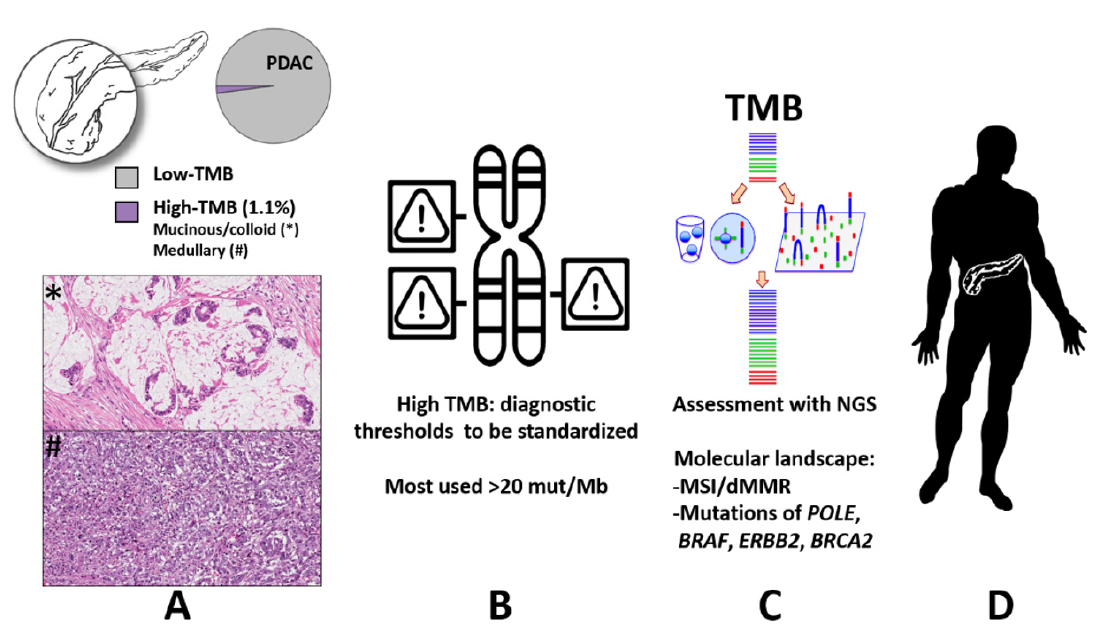
Figure 2. Summarizing figure highlighting the complex landscape related to tumor mutational burden and its potential roles as a biomarker in precision oncology. ( A ) High-tumor mutational burden is relatively rare in pancreatic ductal adenocarcinoma (1.1%), and is enriched in mucinous/colloid and medullary histology (original magnification 10×); ( B ) the most used threshold to distinguish high- vs. low-tumor mutational burden is 20 mutations/Mb; ( C ) tumor mutational burden is assessed with next-generation sequencing, and pancreatic cancers with high-tumor mutational burden display a peculiar molecular landscape, including microsatellite instability/defective mismatch repair, and mutations affecting POLE , BRAF , ERBB2 and BRCA2 genes; ( D ) the routine assessment of tumor mutational burden should be intended as an important step towards the implementation of precision oncology for patients affected by pancreatic cancer. Abbreviations: TMB: tumor mutational burden; mut/Mb: mutations per megabase; NGS: next-generation sequencing; MSI: microsatellite instability; dMMR: defective mismatch